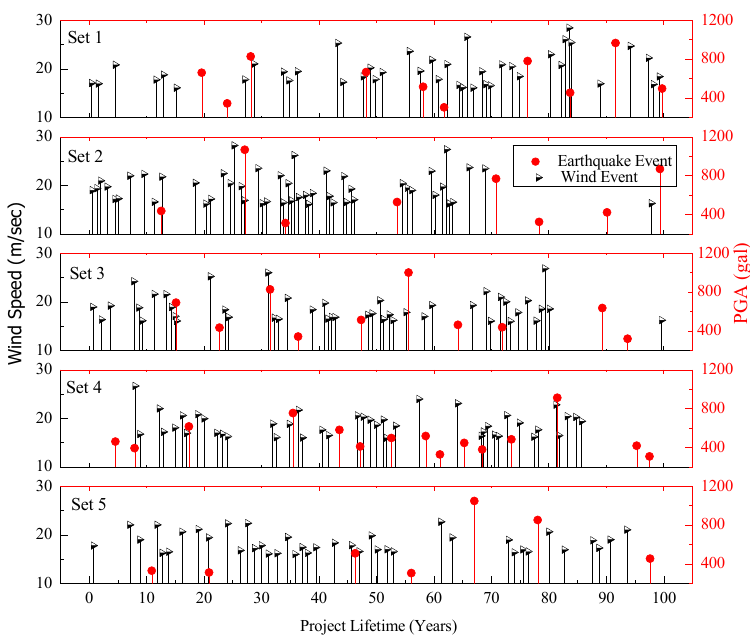
Figure 14. Probable multi-hazard scenarios in the target building lifetime.